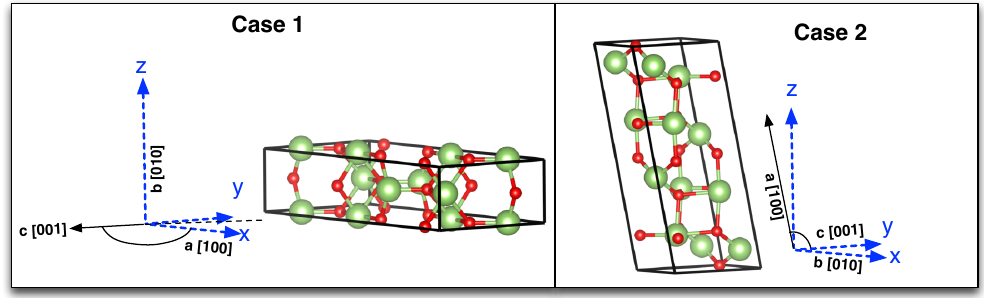
Figure 3. Two cases of different crystal orientations.